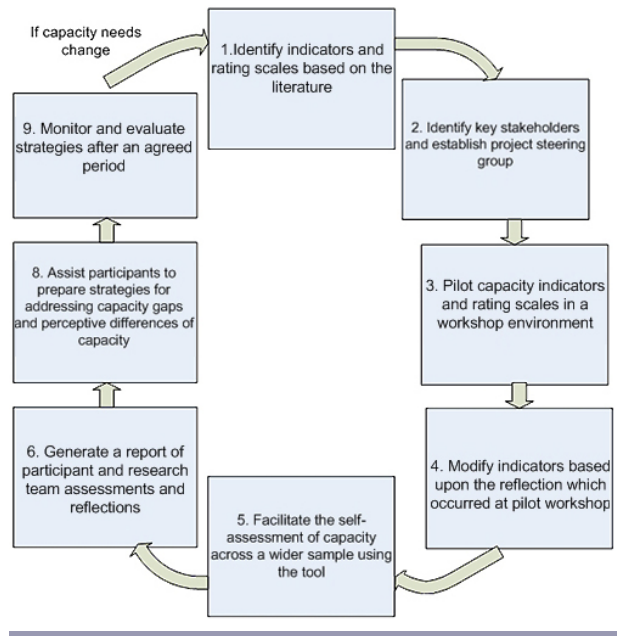
Fig. 1. The process for assessing and reflecting on community